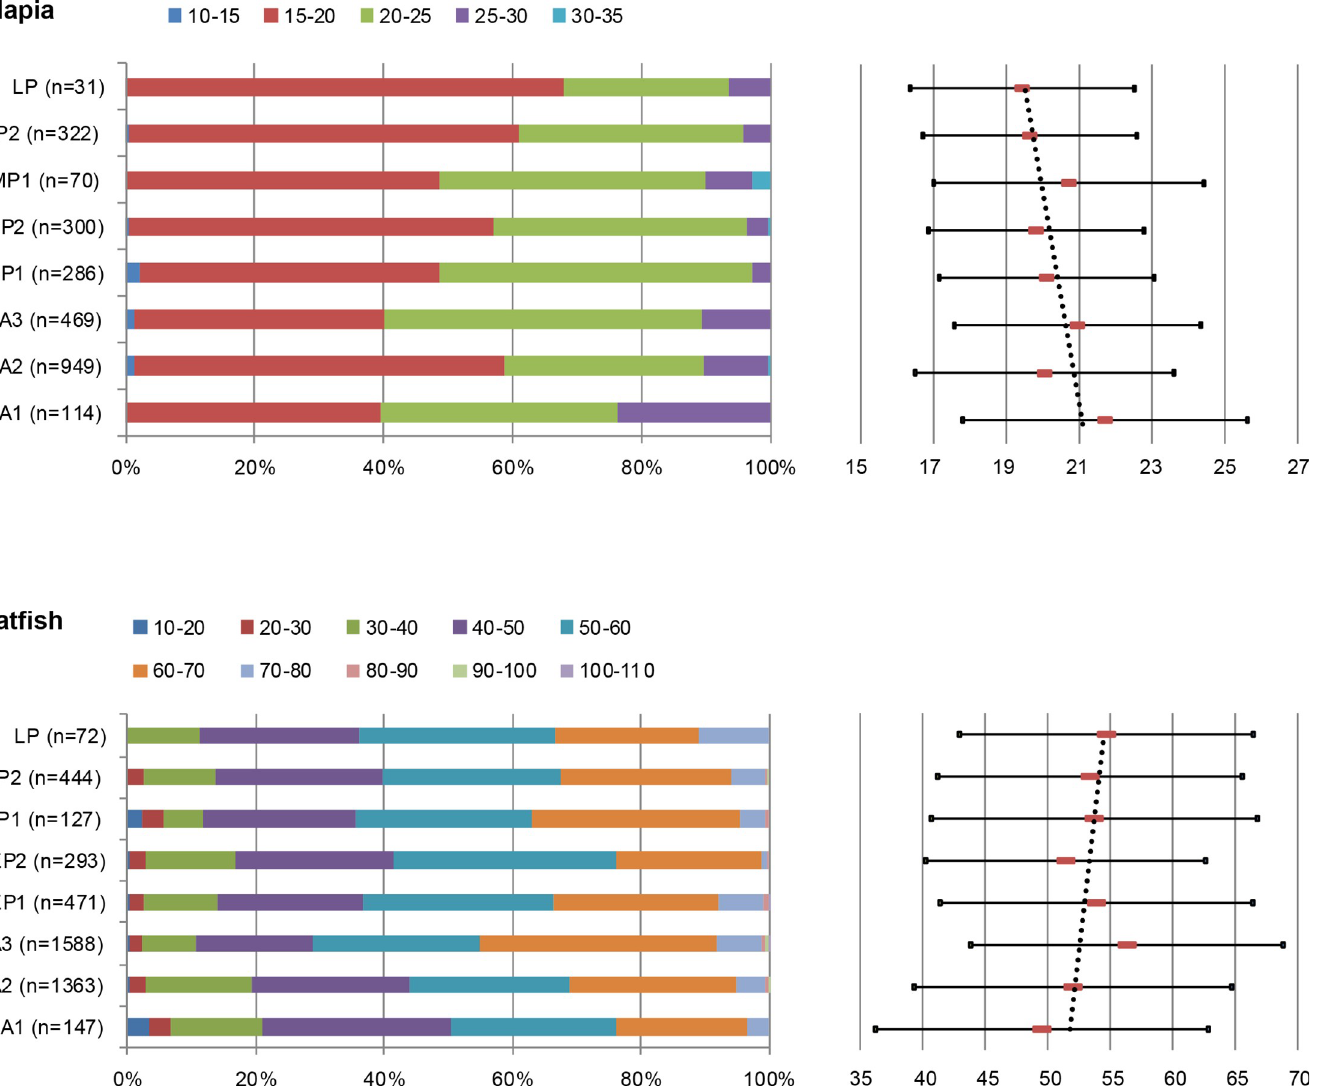
Fig 12. Diachronic changes in the size of the tilapia and catfish. The left pane indicates the % contribution of each of the length classes and in the right pane, the mean length and the ± standard deviations are